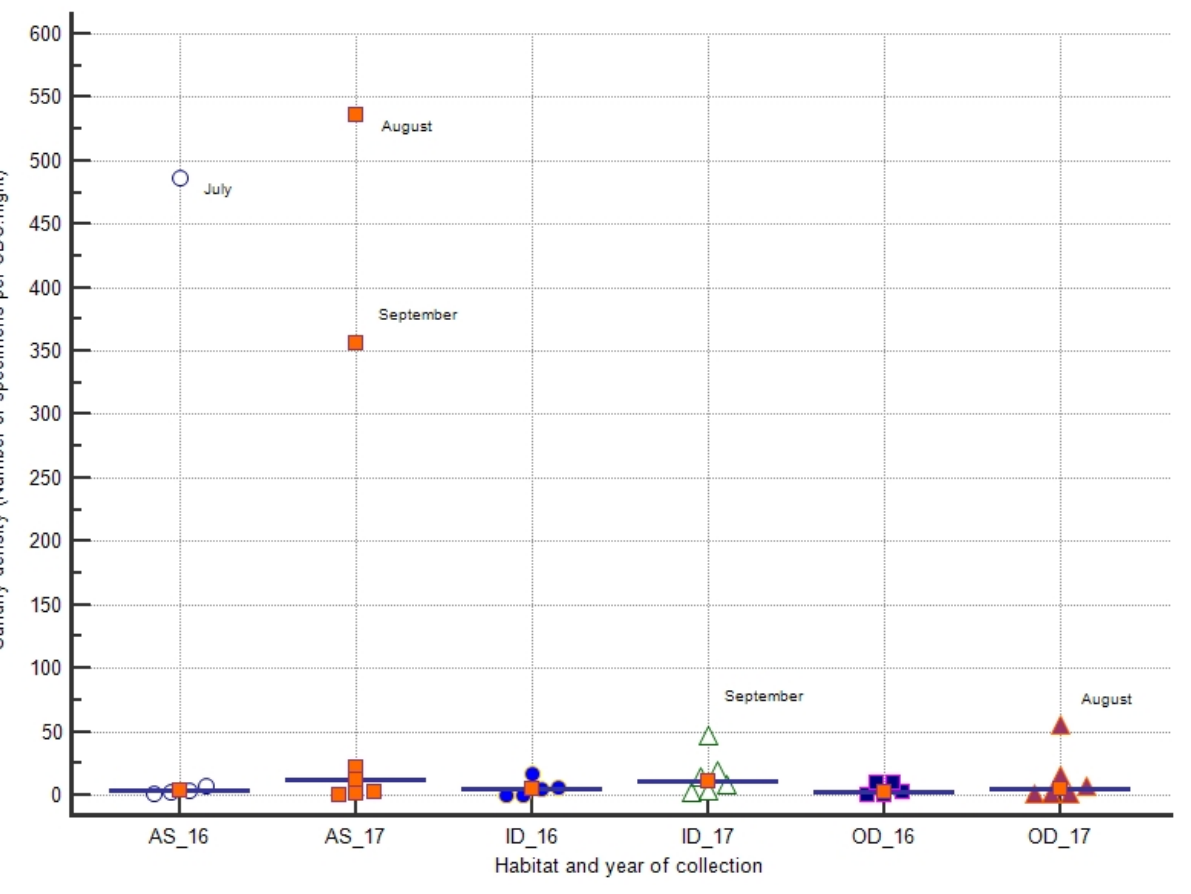
Figure 3. Sandfly densities according to habitat and year of capture. All monthly sandfly densities recorded by habitat and year of capture are plotted. For each group of sandfly collection, the median density is reported by a marker and a horizontal line.